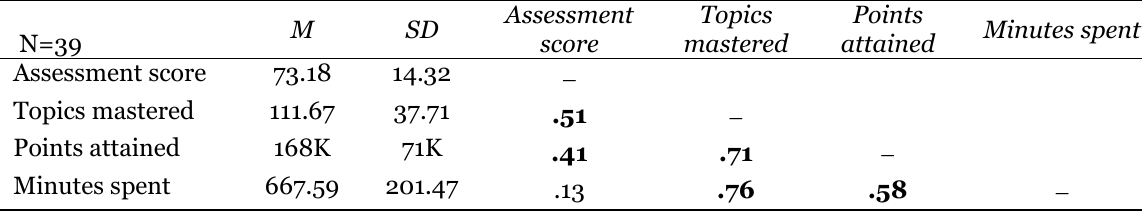
Khan Academy Metrics Correlations and Descriptive